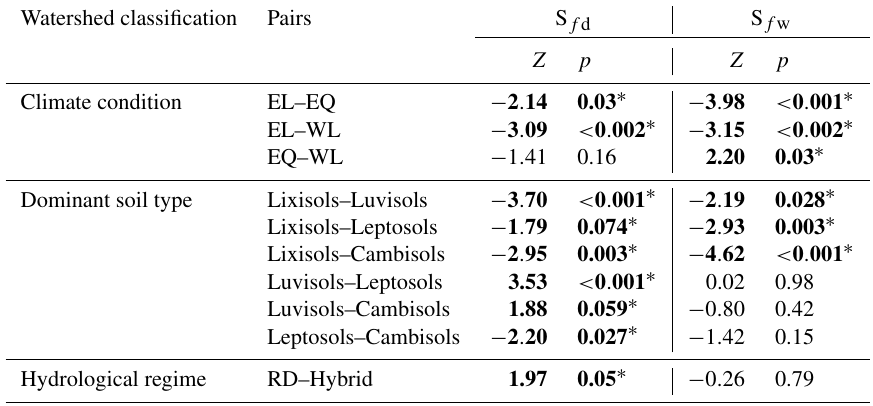
Table 5. Mann–Whitney U tests for the differences in seasonal ecohydrological sensitivity between climate condition, dominant soil type and hydrological regime.